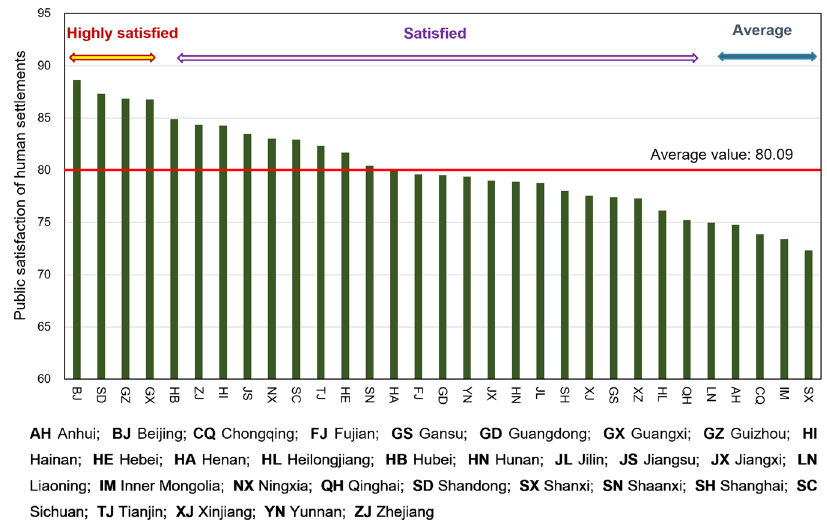
Fig. 5 Public satisfaction with urban-rural human settlements in 2020. The results of 31 regions are arranged in descending order. The national average value of public satisfaction with human settlements was also plotted in red